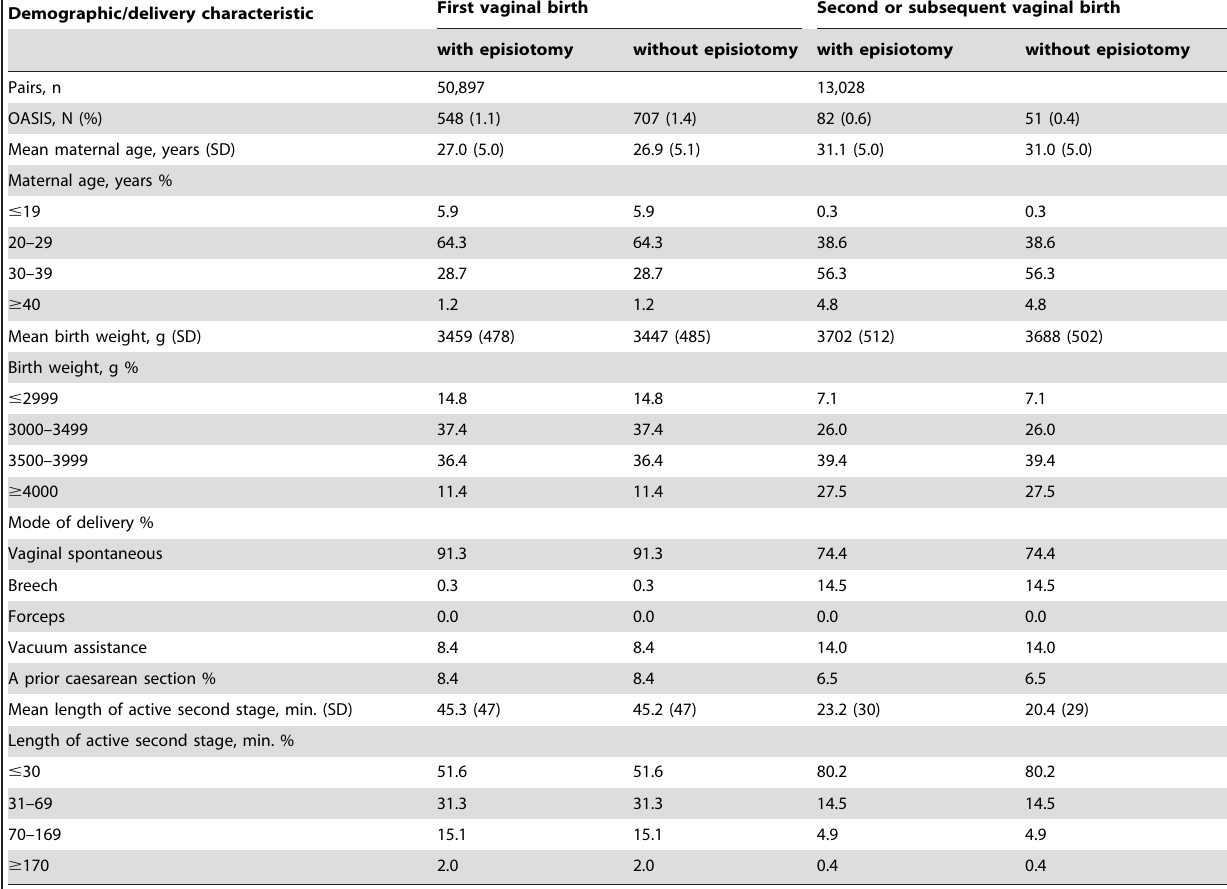
Table 4. Demographics and delivery characteristics for women with matched baseline risk of OASIS with and without episiotomy separately for women with first vaginal singleton births including women with first vaginal birth after a prior caesarean section and second or subsequent vaginal births in 2004–2011 in